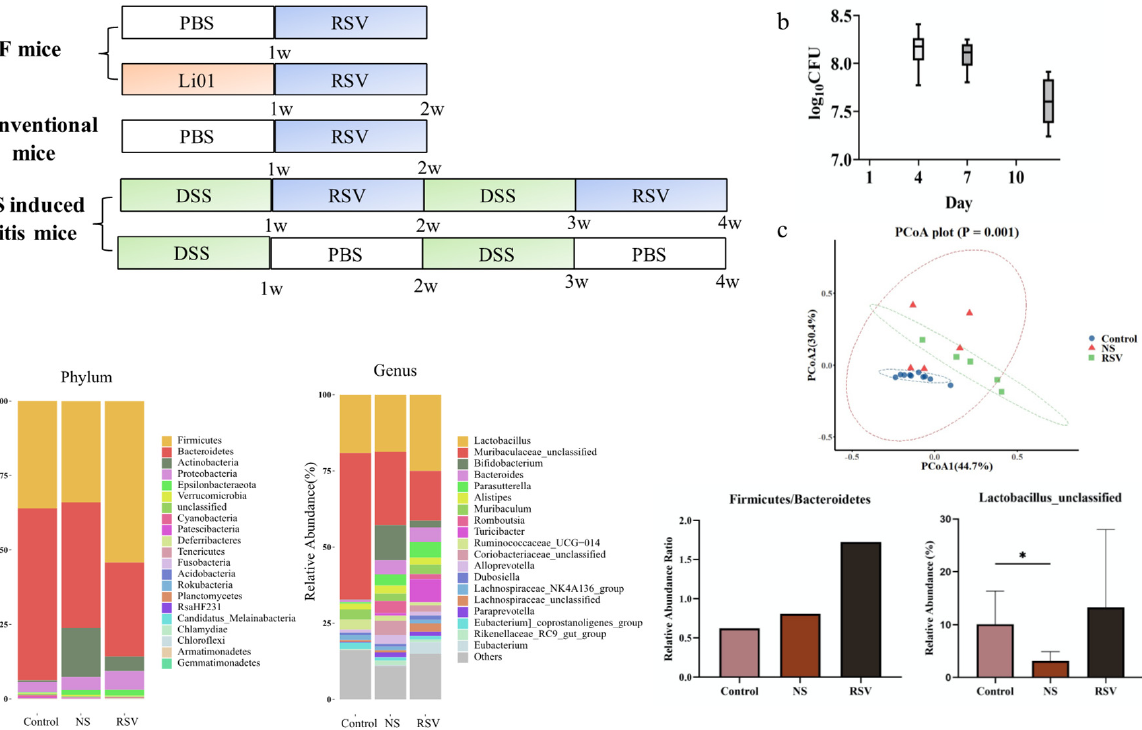
Figure 2. Gut microbiota composition in different mouse models. ( a ) Flow chart of animal studies in germ-free mice, conventional, and DSS-induced colitis mice. ( b ) Impact of RSV on colonized Li01 in germ-free mice. ( c ) Beta diversity evaluated by principal coordinates analysis (PCoA) of weighted unifrac distance. PCoA1 and PCoA2 represent the top two principal coordinates that captured most of the diversity. The fraction of diversity captured by the coordinate is given as a percentage. Groups were compared using analysis of similarities (ANOSIM) method. ( d ) Gut microbiota composition in healthy mice and DSS-induced colitis mice (before and after RSV intervention) analyzed by 16S rRNA gene sequencing analysis. Data are presented as mean ± SD. Significant difference was represented by * p < 0.05, and analyzed by a one-way ANOVA with LSD’s post hoc test. Conventional mice and DSS-induced colitis mice were used as other models. Figure 2c, d show the gut microbiota composition of DSS-induced colitis mice (NS group) and healthy conventional mice (control group) based on 16S rRNA gene sequencing. The